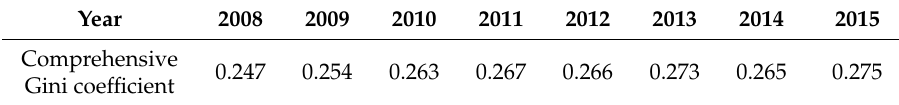
Table 1. Comprehensive Gini coefficient in Jilin Province from 2008 to